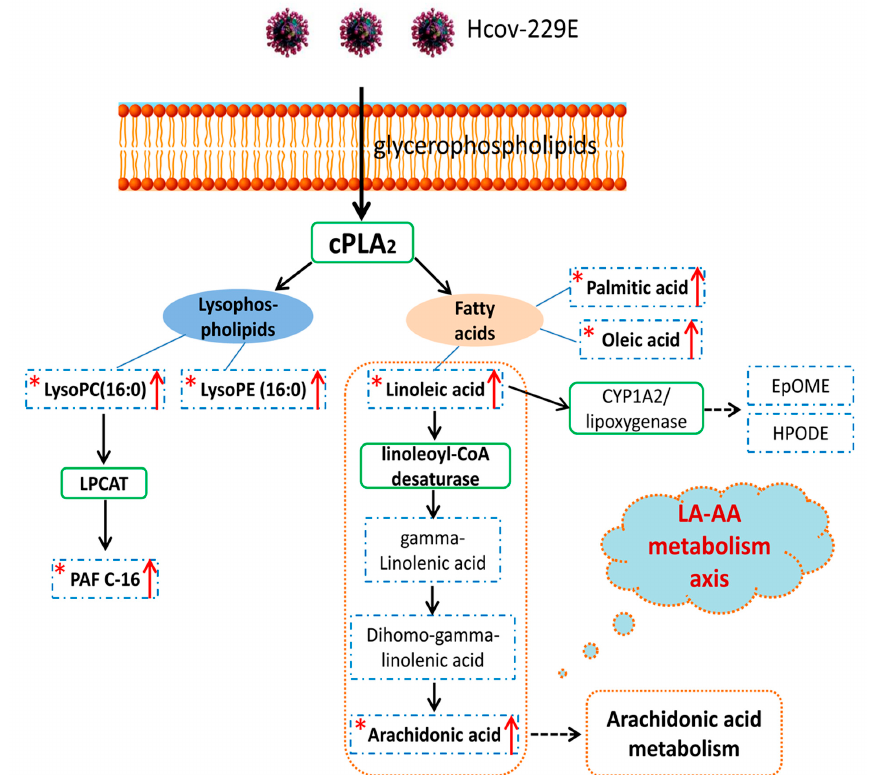
Figure 5. The pathway map based on identified lipids and linoleic acid metabolism recorded in the Kyoto Encyclopedia of Genes and Genomes (KEGG) PATHWAY Database. The star mark “ * ” indicates the lipids could be matched with commercial standards and have an up-regulation trend. The red arrow represents the up-regulation trend. The blue dashed rectangle and green solid rectangles represent lipids and corresponding enzyme in this pathway, respectively. The orange dashed line represents the LA–AA metabolism axis.